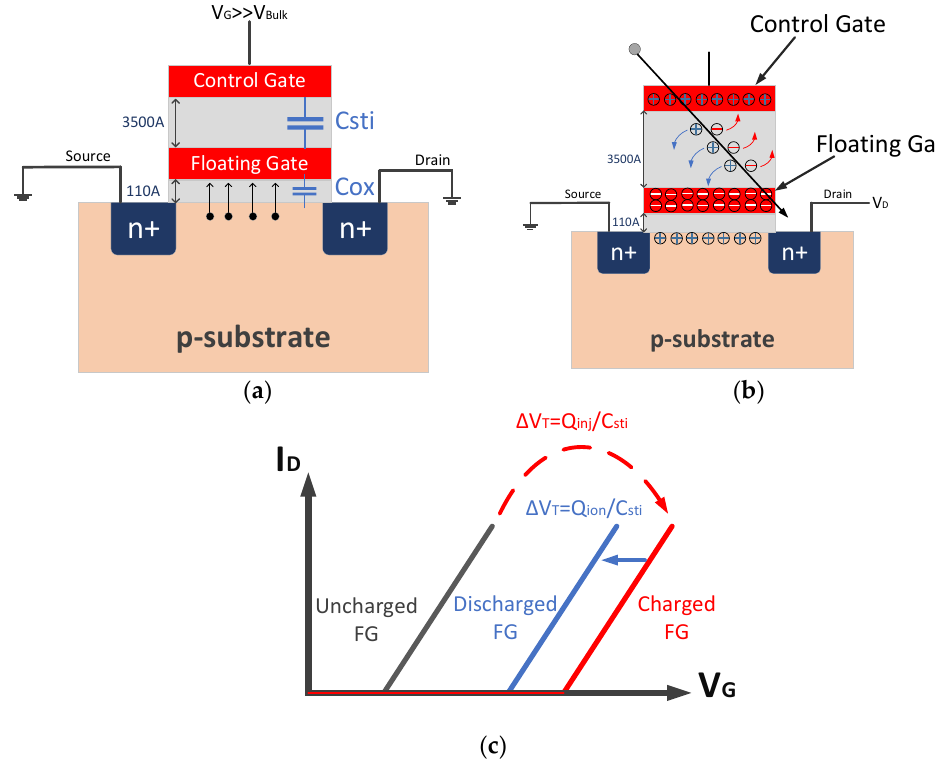
Figure 1. FG transistor radiation response illustration: ( a ) Sensing capacitor charging. ( b ) e–h generation and separation. ( c ) Threshold voltage shift: C sti —sensing area capacitance; Q inj —injected charge by FN tunneling; Q ion —ionized charge in an alpha